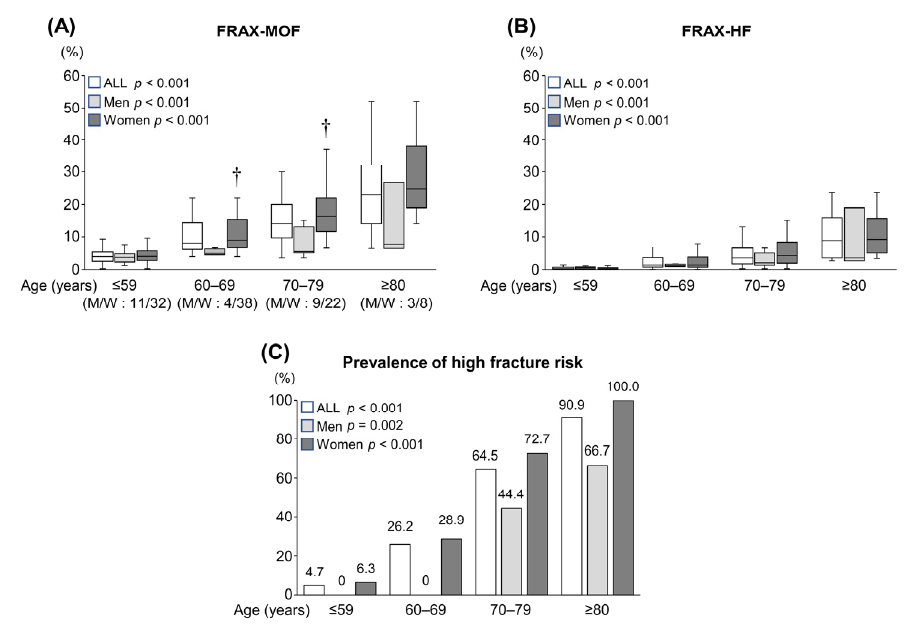
Figure 1. The 10-year probabilities of major osteoporotic fracture (FRAX-MOF) and hip fracture (FRAX-HF) and the prevalence of high fracture risk among the four age groups. ( A ) The FRAX-MOF significantly increased stepwise with advancing age. † Women had significantly higher FRAX-MOF than men. ( B ) The FRAX-HF significantly increased stepwise with advancing age. ( C ) The prevalence of high fracture risk significantly increased stepwise with advancing age. The numbers on each bar indicate the percentage of patients with high fracture risk. M/W, Men/Women; FRAX, Fracture Risk Assessment Tool. † p < 0.05.